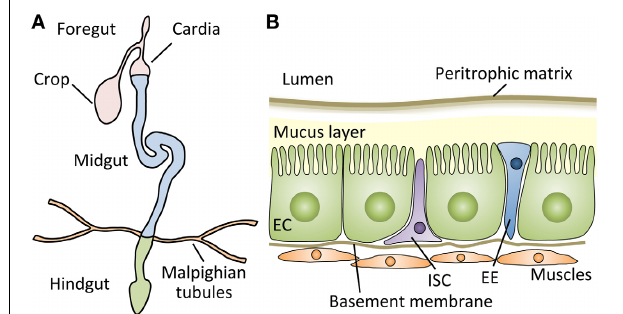
FIGURE 1 | The structure of the Drosophila gut. (A) Schematic representation of the digestive tract of the Drosophila adult. The Drosophila gut is a tubular epithelial organ composed of a monolayer of cells surrounded by muscles. The gut is divided into the foregut, the midgut, and the hindgut, based on the developmental origin. The crop stores the food ingested by the flies, and the first half of the cardia belongs to the foregut. The Malpighian tubules, a functional equivalent of the mammalian kidney, connect at the midgut-hindgut junction. The midgut is the main site of digestion, and most studies of Drosophila gut immunity have focused on this compartment. (B) A cross section of the adult Drosophila midgut. The adult midgut contains several types of cells: absorptive enterocytes (ECs), secretory enteroendocrine cells (EEs), and pluripotent intestinal stem cells (ISCs). Muscle cells are present under the basement membrane of epithelial cells. Between the lumen and epithelia, a semipermeable non-cellular structure, the peritrophic matrix, protects the enterocytes from abrasive particles and pathogens. In addition, a mucus layer lies between the peritrophic matrix and ECs along the midgut (Ridley et al.,